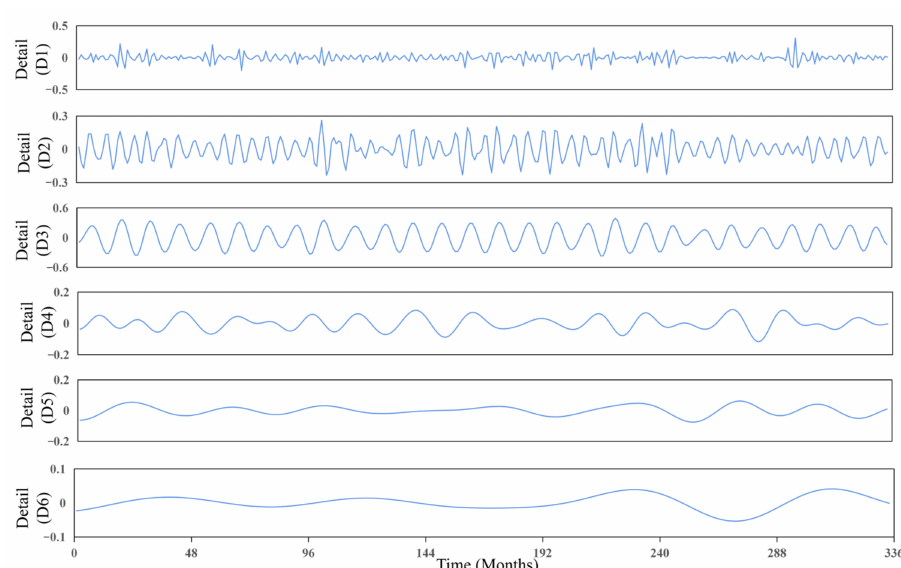
Figure 8. Trend term of the runoff original series.